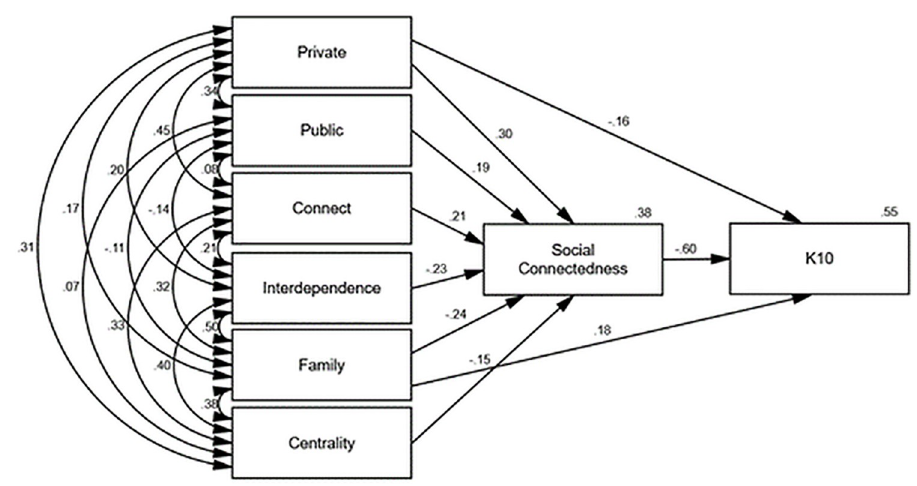
Fig 2. Final path model with standardised parameter estimates Kessler psychological distress scale (K10).